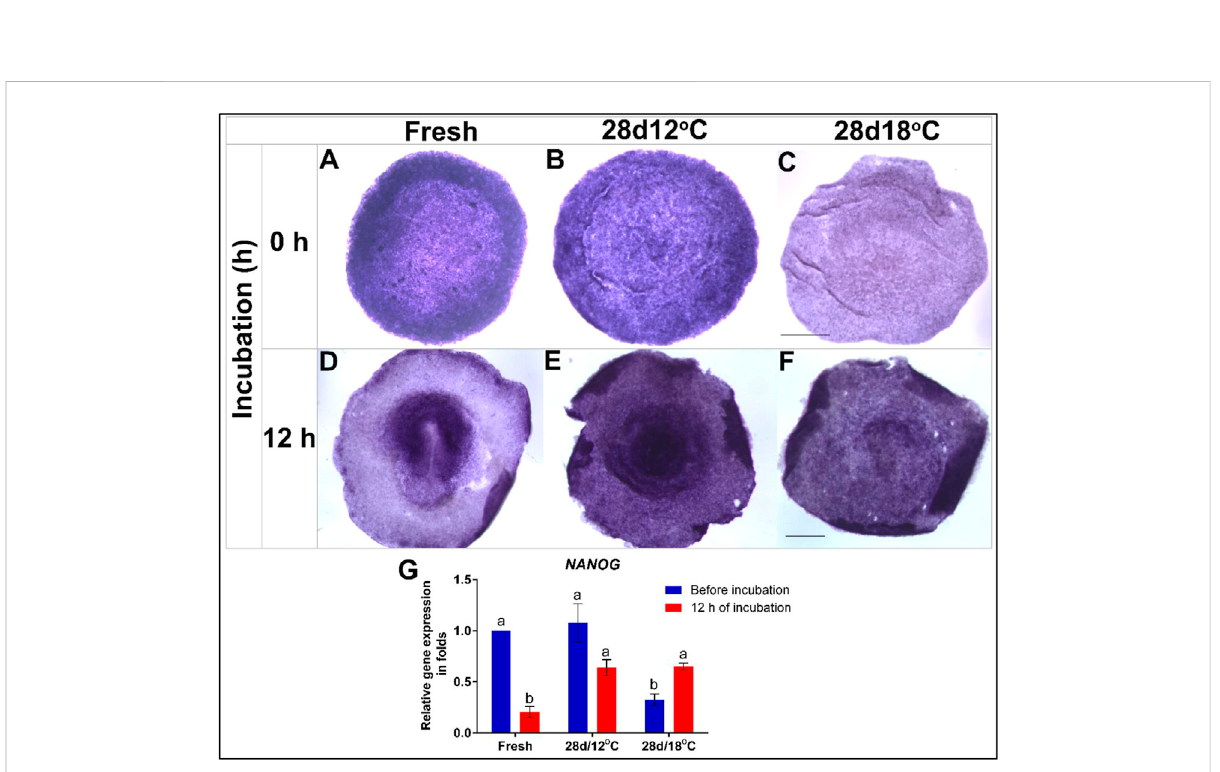
FIGURE 2 Expression of NANOG gene in embryos following storage, and following 12 h of incubation in the resumption phase. (A – C) WMISH analysis of NANOG expressioninfreshly-laid embryo (XI EG&K) orinembryos stored for 28 daysat12 ° C(XIIEG&K), or 18 ° C(XIII EG&K). (D – F) WMISH analysis of NANOG expressionfollowing12 hofincubationofthesameembryonicgroups. (G) Quanti fi cationof NANOG geneexpressionin6differentembryo groups using RT-real-time PCR. GAPDH was used for normalization of NANOG gene expression. One-way ANOVA statistical analysis of 6 different embryo groups-different connecting letters denote that the expression of NANOG is signi fi cantly different between groups; F value = 16.51; Fresh, a vs. b: p < 0.0001; 28 days/18 ° C, a vs. b: p = 0.0357; Fresh (before incubation) vs. 28days/18 ° C (before incubation), a vs. b: p = 0.0008; 28 days/12 ° C(beforeincubation)vs.28 days/18 ° C(beforeincubation), avs.b: p =0.0007; Fresh(afterincubation)vs.28 days/12 ° C(afterincubation), a vs. b: p = 0.0023; Fresh (after incubation) vs. 28 days/18 ° C (after incubation), a vs. b: p = 0.0018). Bar = 1